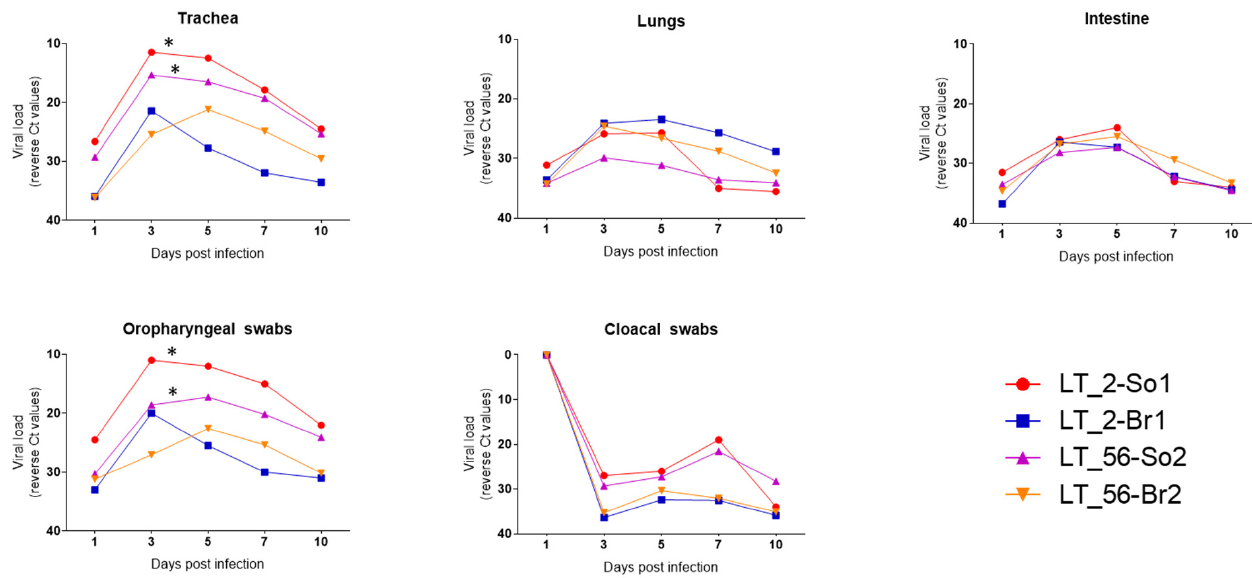
Figure 6. Kinetics of H9N2 virus replication and shedding upon experimental infections in Sonali and broiler chickens. The samples that showed value of >40 considered as negative and in the graph represent as zero (0). The graphs showed the Ct values generated at RT-qPCR targeting H9 gene in organs (trachea, lungs, intestine) and swabs (oropharyngeal and cloacal) sample. In general, virus replication progressively increased at 3 and 5 dpi whereas, progressively started to decline from 7 dpi up to 10 dpi. In most cases, viral load is higher in Sonali chicken compared with broiler. No significant differences between two viruses (LT_2 and LT_56) in each infected chicken group. Asterisk (*) indicates level of significance ( p <